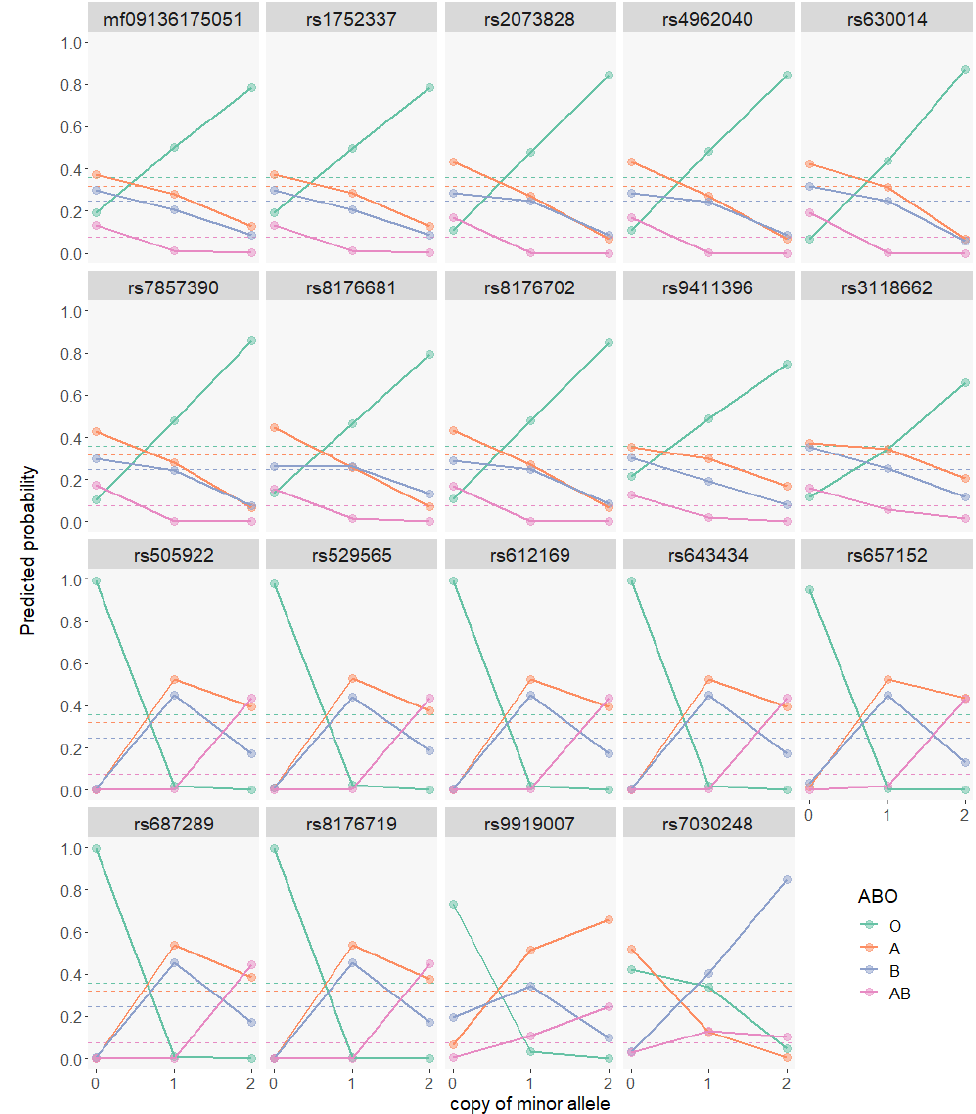
Figure 2. Predicted probability of individual’s ABO blood types based on 19 hit SNPs shared among the multinomial models. The dashed horizontal lines annotate the prevalence of respective ABO blood types in the cohort.